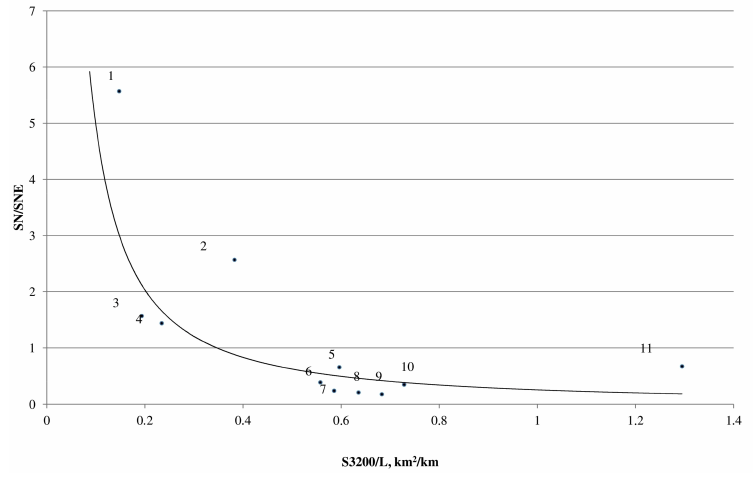
Figure 3. Correlation (correlation coefficient − 0.6) between the average ratio of the areas of plateaus at heights over 3200 m (S3200, km 2 ) to the length of the corresponding section of the mountain ridge (L, km) and the ratio of the areas of the glaciers with northern aspect ( S n , km 2 ) to the areas of the glaciers with northeastern aspect (S ne , km 2 ). Glaciation centers: 1 : Tavan Bogd (northern slope); 2 : Hunguyn-Nuru; 3 : Chihacheva (Ikh Turgen); 4 : Turgen; 5 : Saylugem; 6 : Mongun-Taiga; 7 : Kharkhiraa; 8 : Sair; 9 : Tsengel Khairkhan; 10 : Nayramdal; 11 :